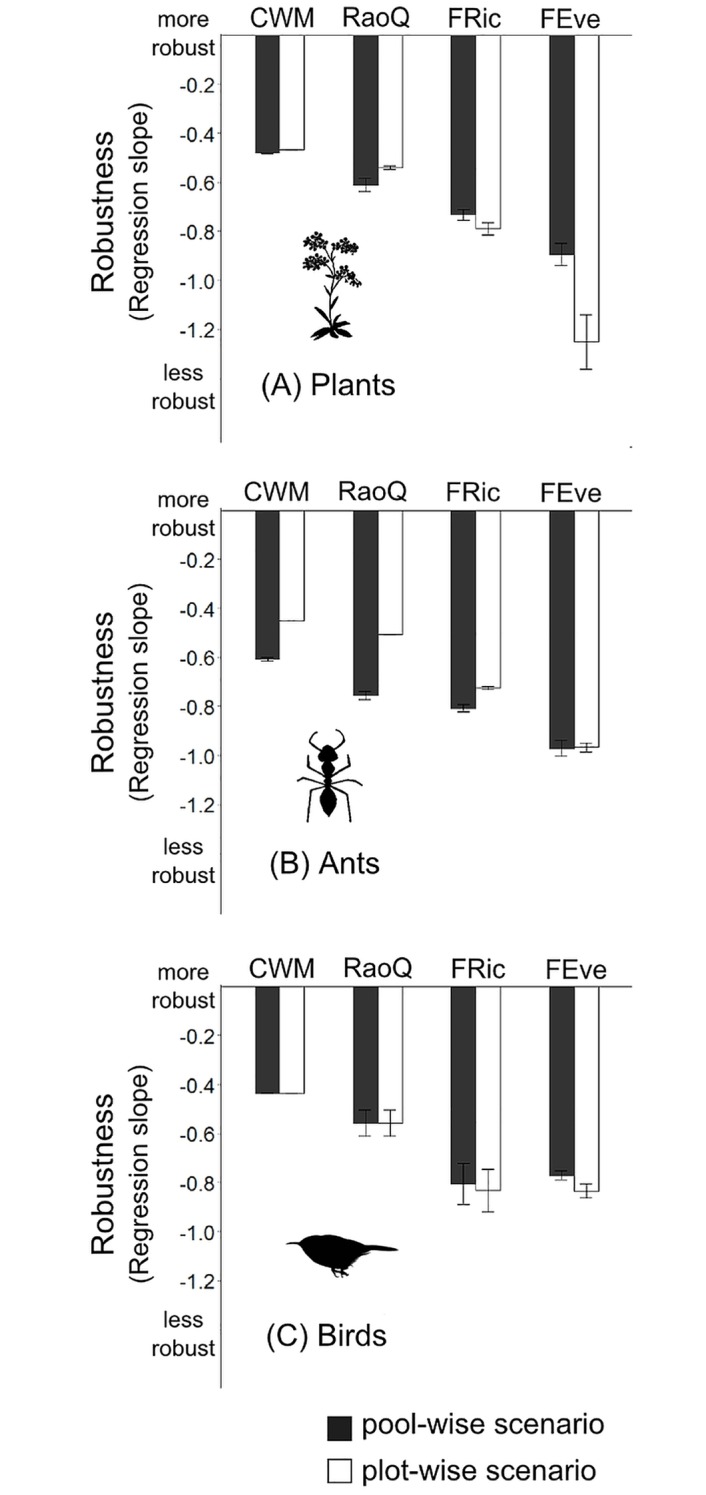
Effect of sampling scenario on FD index sensitivity.Barplots showing the results of linear mixed effects model, specifically the effect of the two sampling scenarios on the sensitivity of indices for three different types of organisms. The more negative the regression slope, the more sensitive the particular index is to missing trait information. The error bars denote the 95% confidence intervals. (A) plant community (n = 12 plots), (B) ant community (n = 58 plots), and (C) bird community (n = 8 plots).